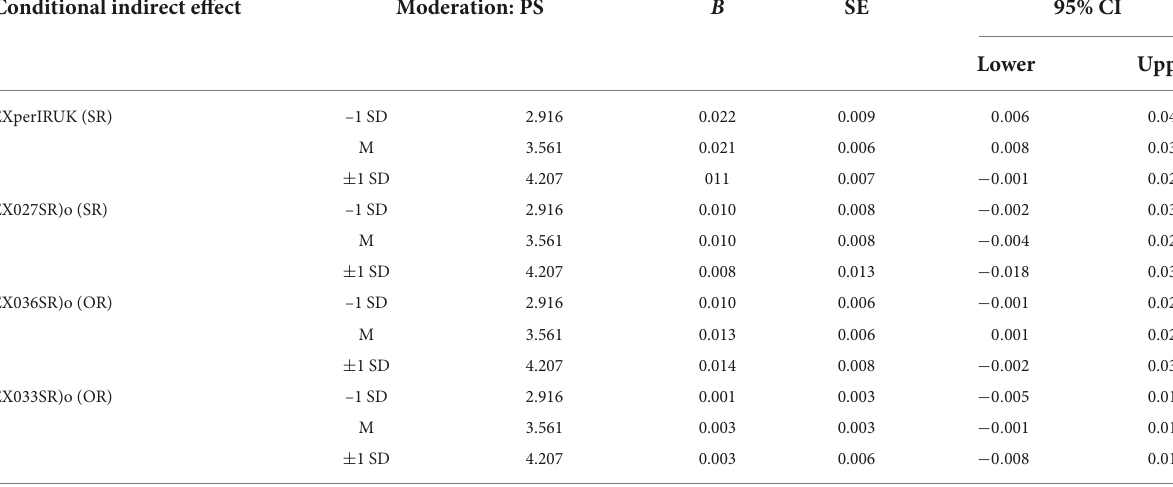
TABLE 7 Moderated mediation conditional indirect effect of experience on receiving useful